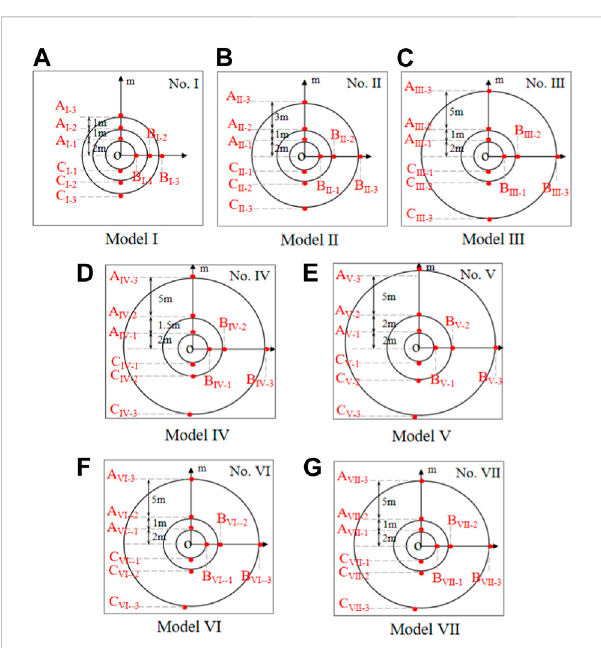
FIGURE 8 The monitoring points ’ layout and numbering in (A) model I,